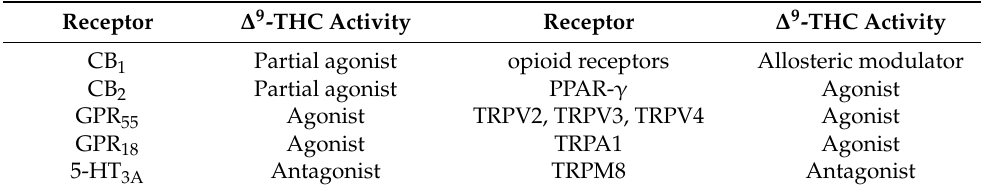
Table 2. The effect of ∆ 9 -tetrahydrocannabinol ( ∆ 9 -THC) on the receptors